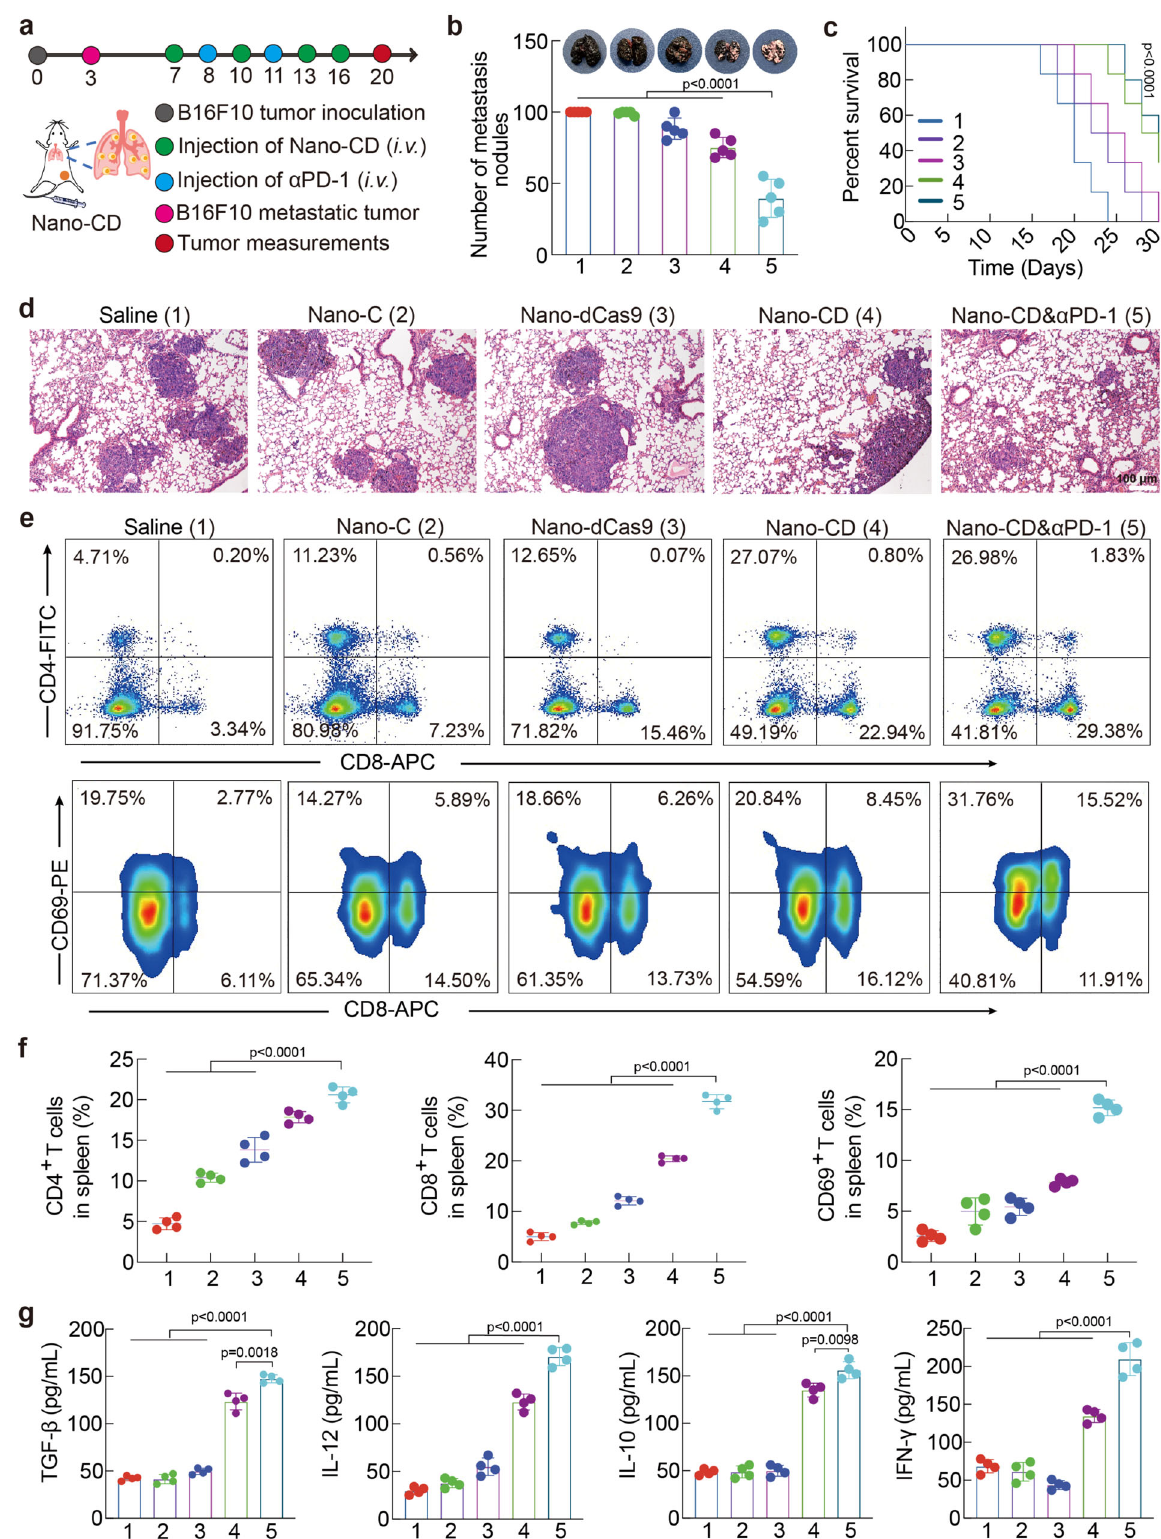
Fig.7|Assessmentoftherapeuticef fi cacyofNano-CDinmelanomapulmonary metastasis model. a Schematic illustration of administration schedule in vivo. b Thenumberofnodulesonthelungswascountedandthelungsfromeachgroup was pictured at day 20 ( n =5 biological replicates per group). c Survival curve